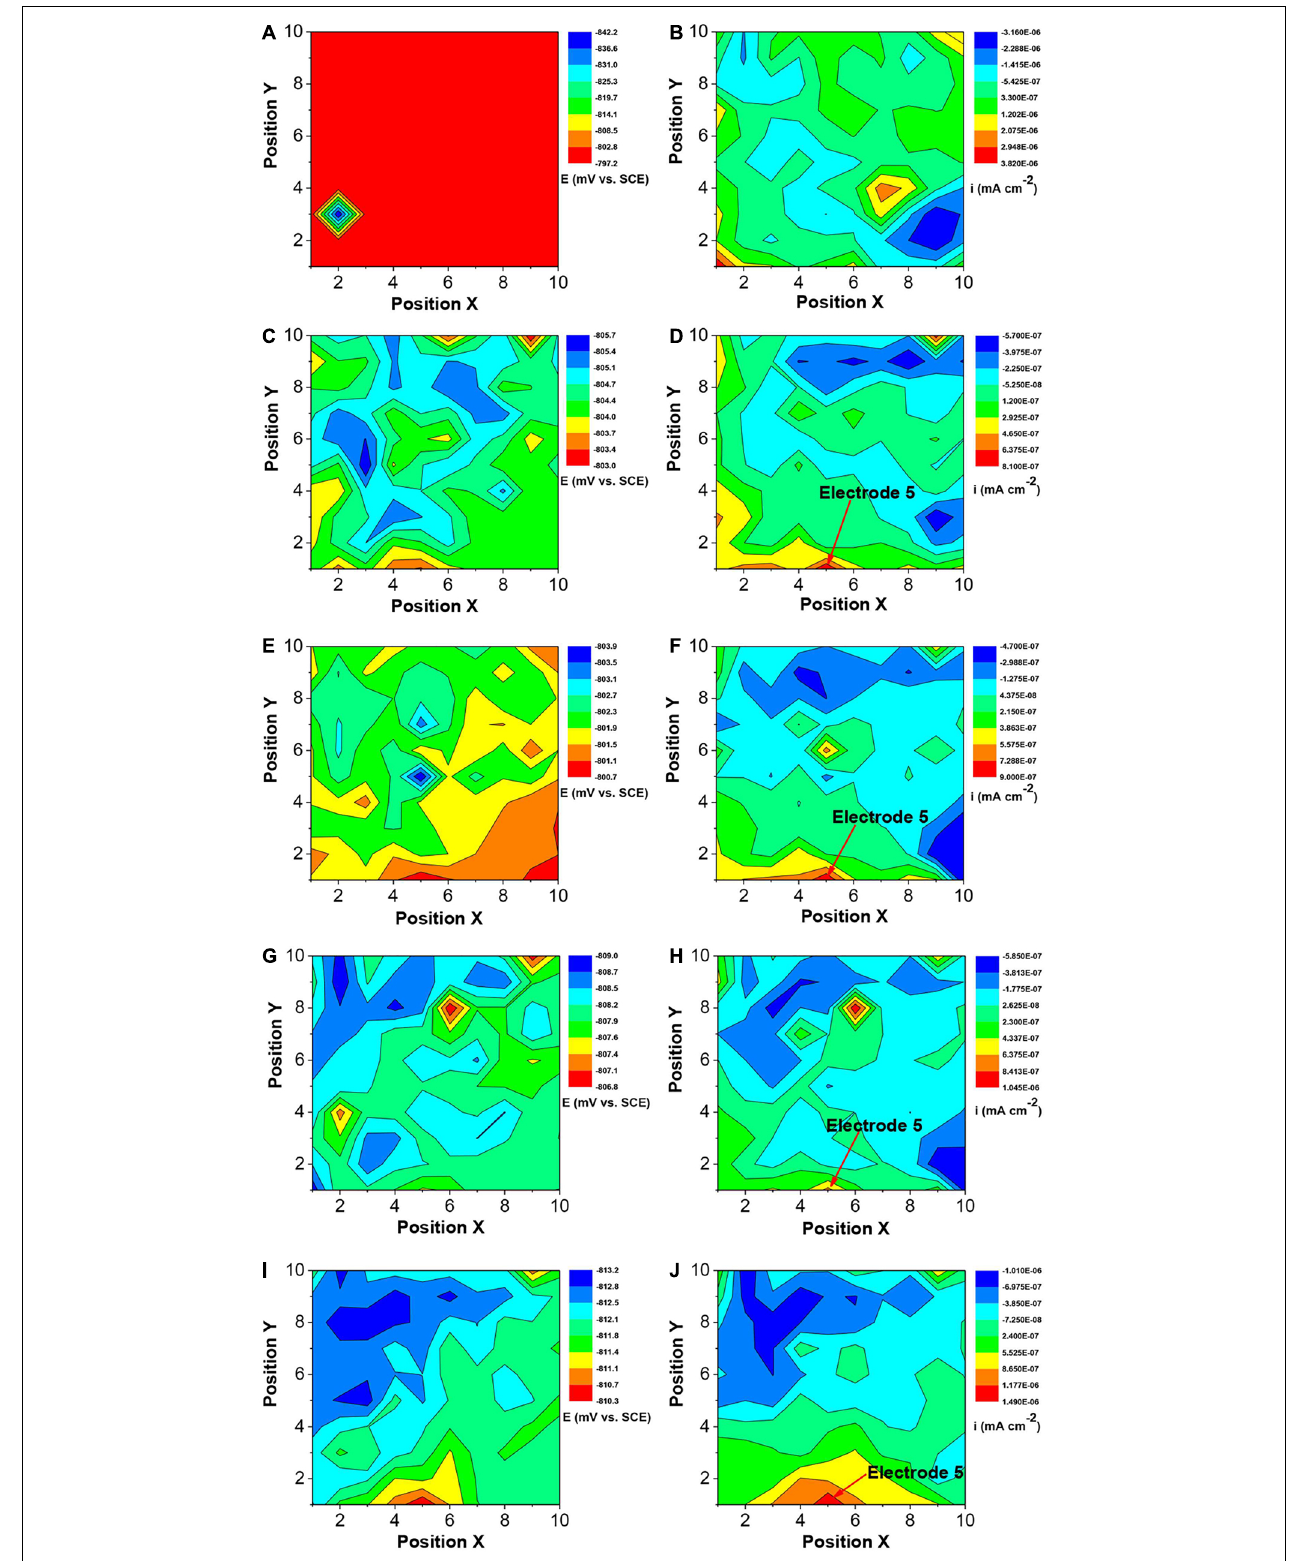
FIGURE 12 | Changes of corrosion potential (A,C,E,G,I) and galvanic current (B,D,F,H,J) distributions of Q235 WBE with incubation time in the absence of SRB in CO 2 -saturated simulated formation water: (A,B) 1 day; (C,D) 4 days; (E,F) 7 days; (G,H) 10 days, and (E,F) 14 days.